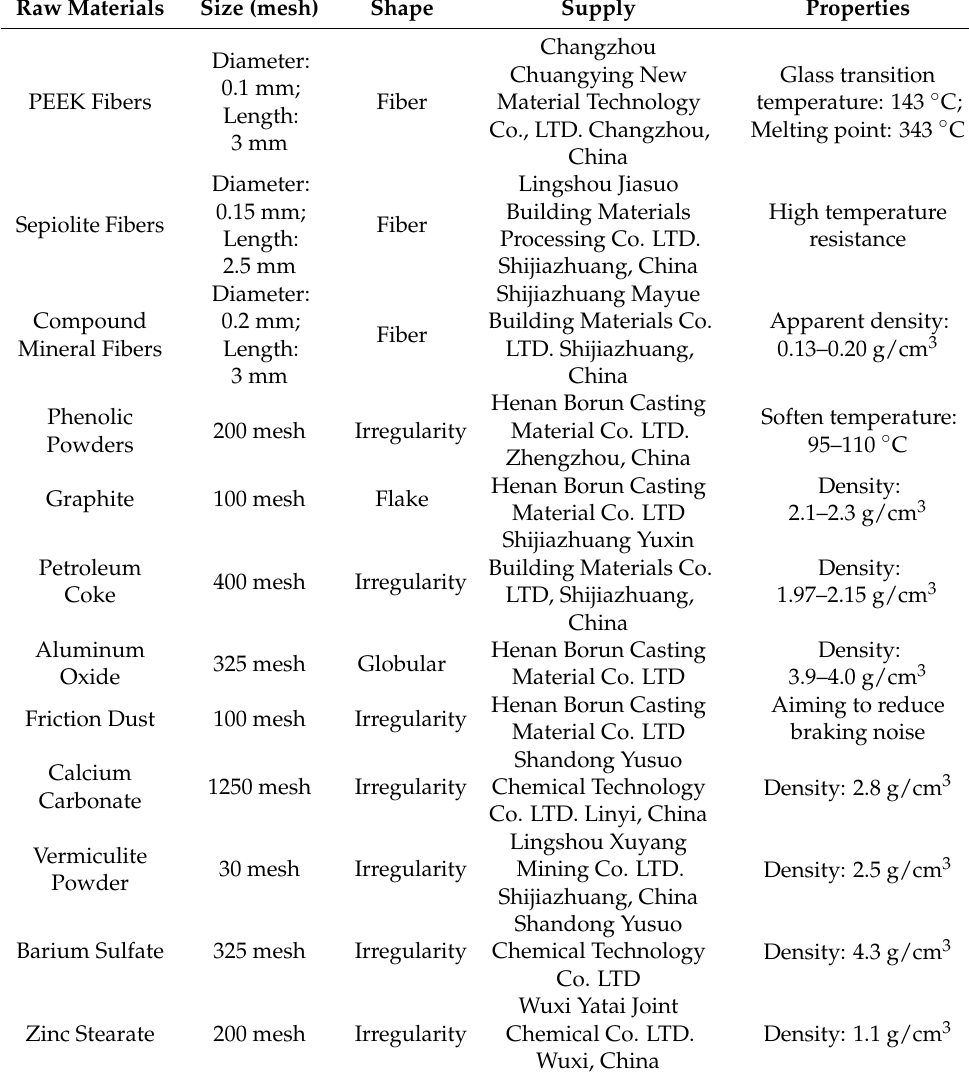
Table 2. The information of raw